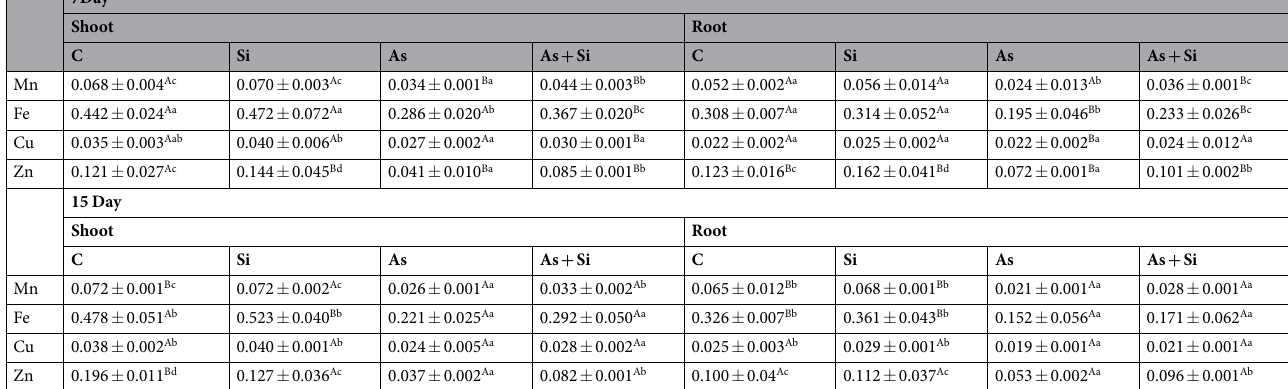
Table 4. Manganese (Mn), Iron (Fe) Copper (Cu) and Zink (Zn) content in shoot and root of Oryza sativa var. IR64 under As (III) and Si supplementation at 7 and 15d exposure period. Values are mean ( ± S.D) of three independent replicates (n = 3). Different letters represent significant differences between each treatment at p < 0.05. The small latter (i.e. a, b, c and d) indicates the significant difference between treatment in same tissue type while capital latter (i.e. A and B) indicates the significant difference between duration among the same treatment in same tissue type.